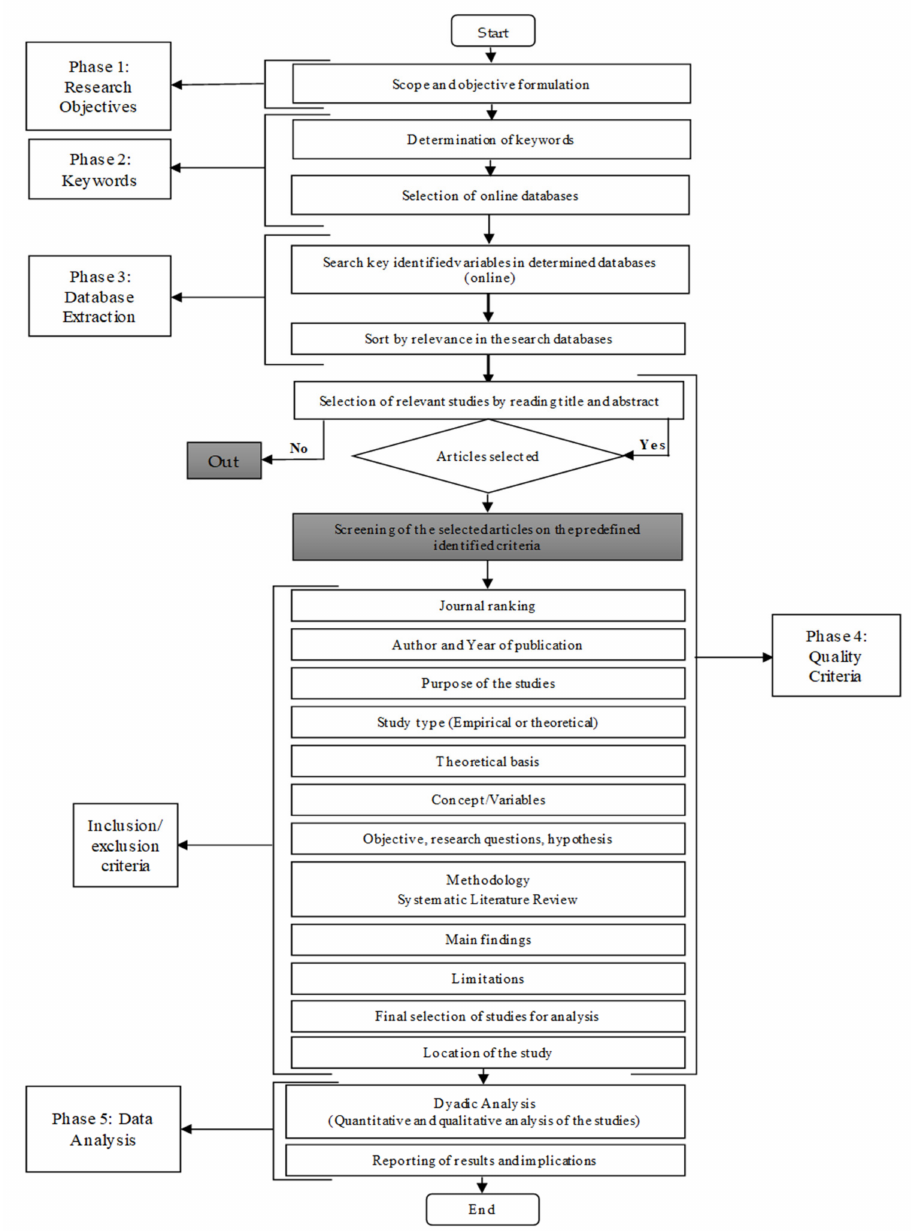
Figure 1. Steps in the systematic literature review (PRISMA flow